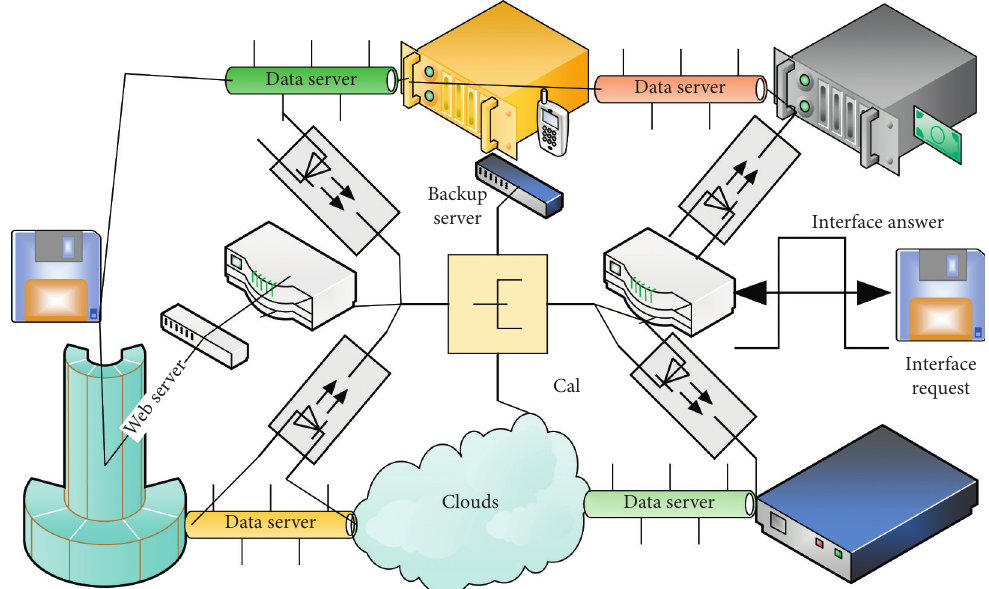
Figure 3: Framework of the rapid design system for arts and crafts with 3D